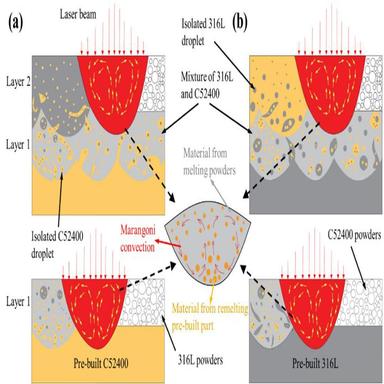
Diagram of melted material behaviour during SLM: (a) C/L interface; (b) L/C interface.